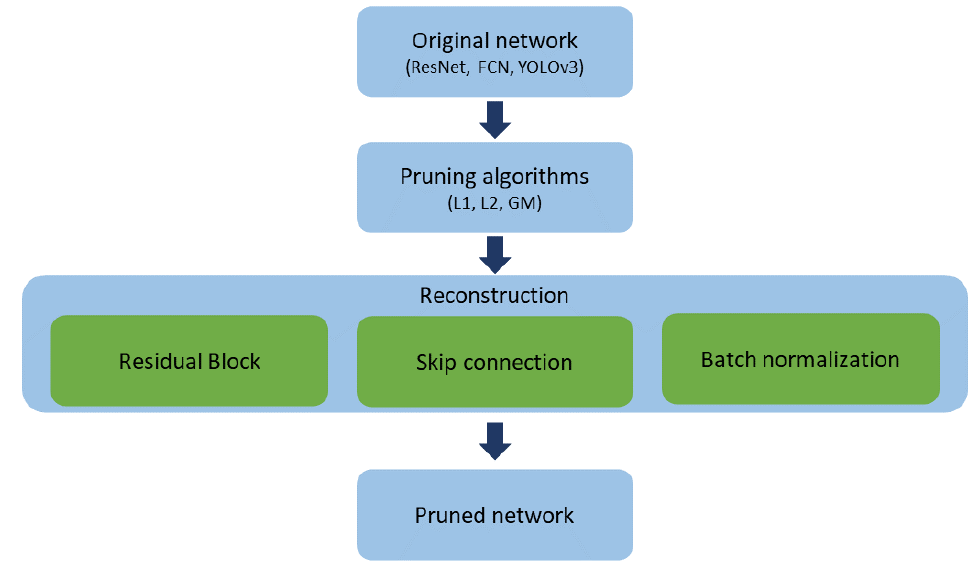
Figure 1. Pruning process with